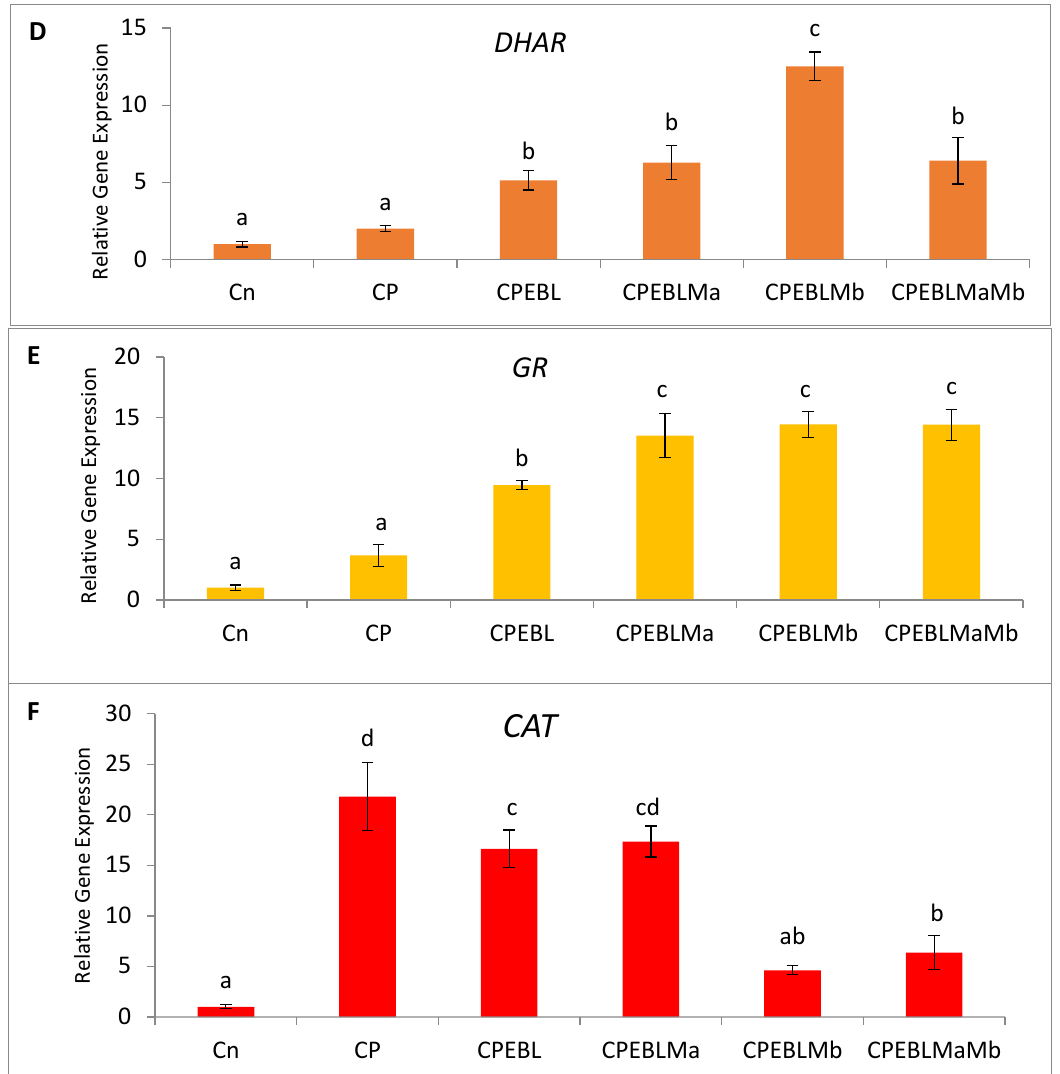
Figure 6. Effect of seed priming with 100 nM of 24-epibrassinolide (EBL) and plant-growth-promoting rhizobacteria ( Pseudomonas aeruginosa (Ma, 10 9 cells/mL) and Burkholderia gladioli (Mb, 10 9 cells/mL)) on gene expression of ( A ) RBOH, ( B ) SOD, ( C ) APOX, ( D ) DHAR, ( E ) GR and ( F ) CAT of 10-day-old B. juncea L. seedlings under chlorpyrifos (CP) toxicity. Data are presented as mean of three replicates ± s.d. (standard deviation). Means were compared using two-way analysis of variance followed by Tukey’s post-hoc test ( p < 0.05). Different superscripts indicate significant difference between treatments.